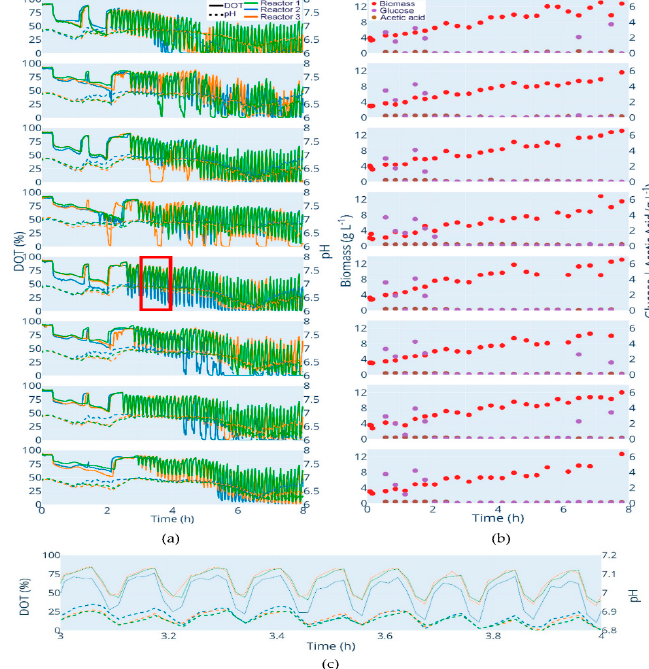
Figure 3. Cultivation data of all strains. Clones from top to bottom: E. coli W3110; E. coli BW25113; E. coli BW25113 Δ ompT ; E. coli BW25113 Δ aceA ; E. coli BW25113 Δ fliA ; E. coli BW25113 Δ gatC ; E. coli BW25113 Δ gatZ ; E. coli BW25113 Δ glcB. ( a ) DOT (%): solid lines, pH: dotted lines. ( b ) Biomass (g L − 1 ): red dots; glucose (g L − 1 ): purple dots; acetic acid (g L − 1 ): brown dot. ( c ) Illustration of the oscillating pH